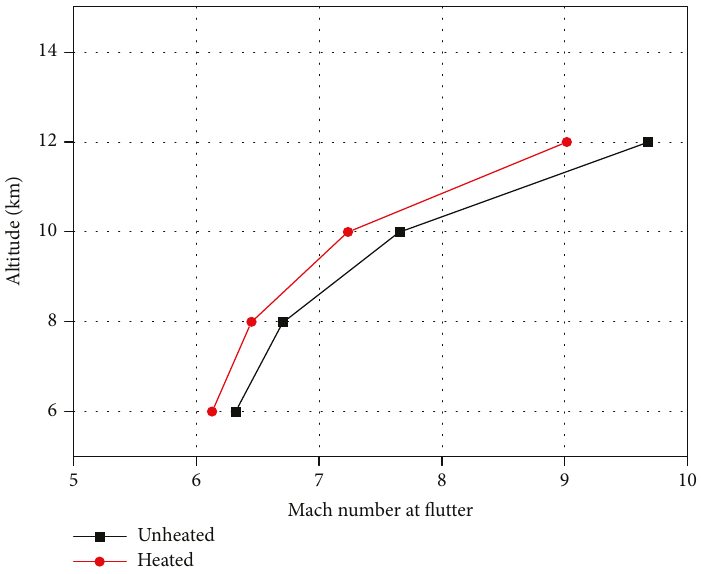
Figure 12: Flutter boundaries of the unheated and heated